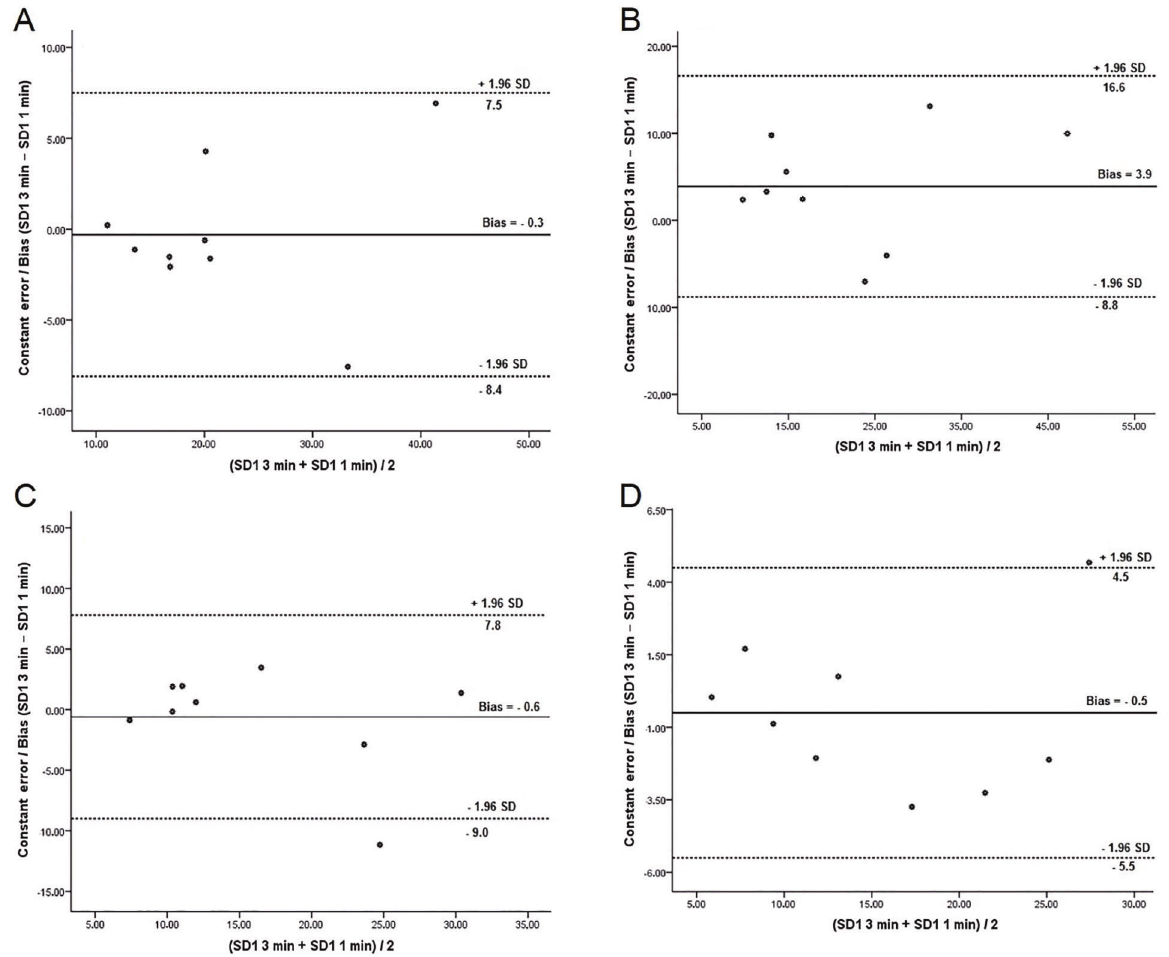
Figure 5. Bland-Altman plots of the differences between SD1 during 3- and 1-min signals at different resistance exercise loads. A , B, C, and D represent 10, 20, 30, and 35% 1-RM. The solid middle line indicates the bias, while the two dashed lines represent the upper and lower limits of agreement. SD1: short-term RRi standard deviation; 1-RM: 1-repetition maximum